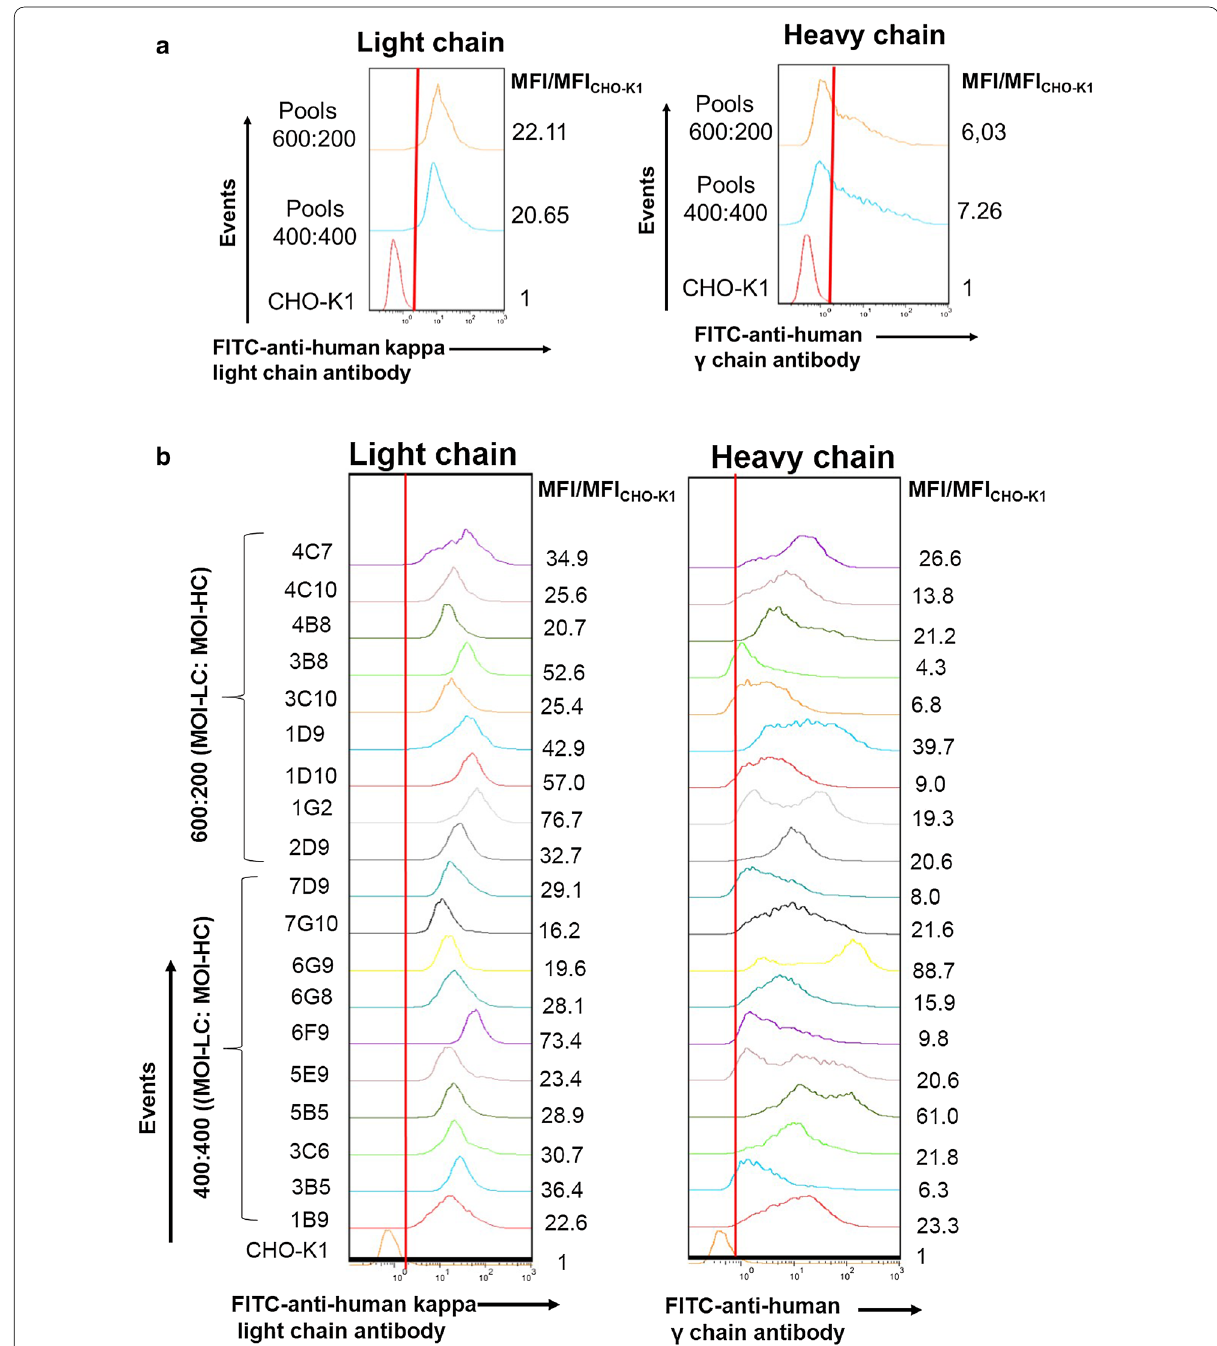
Fig. 3 Assessment of intracellular light and heavy chain polypeptides by flow cytometry. a cell pools. b cell mini‑pools. Intracellular light and heavy chains polypeptides of ethanol fixed cells were measured using a FITC‑labeled goat anti‑human kappa light chain antibody and a FITC‑labeled goat anti‑human IgG (γ chain specific) antibody, respectively. MFI/MFI CHO‑K1 : mean fluorescence intensity of trastuzumab‑expressing cells compared to the mean fluorescence intensity of CHO‑K1 wild type cells